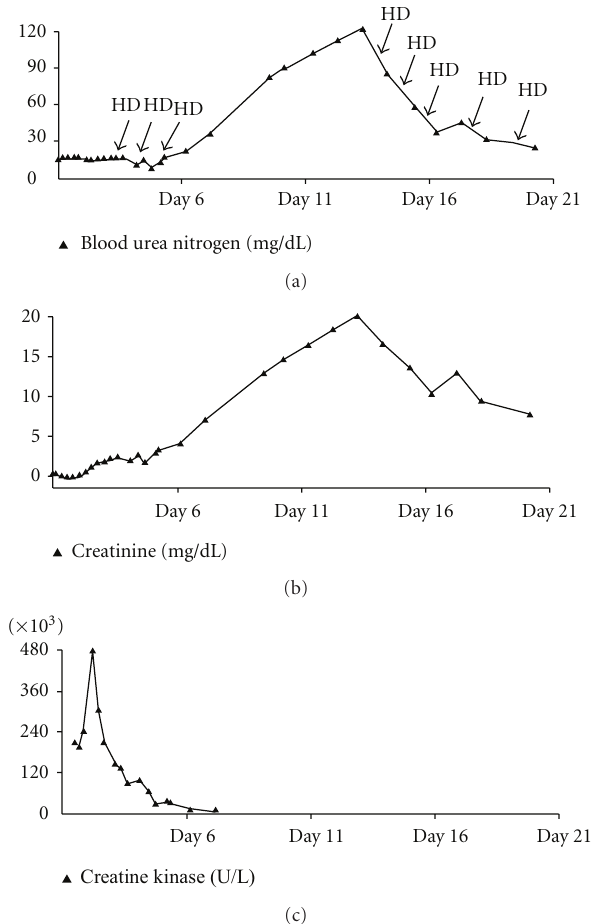
Figure 1: Blood urea nitrogen, creatinine, creatine kinase, and hemodialysis treatments. HD: intermittent hemodialysis